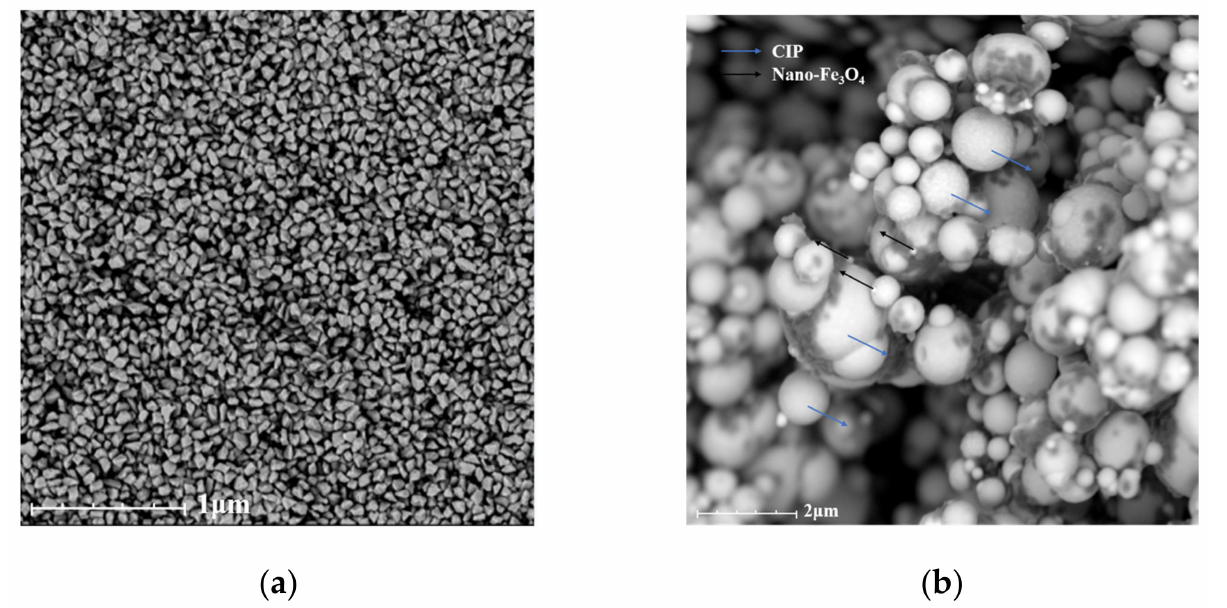
Figure 6. ( a ) SEM image of nanodiamond abrasive; ( b ) CIP mixed with nano-Fe 3 O 4 .